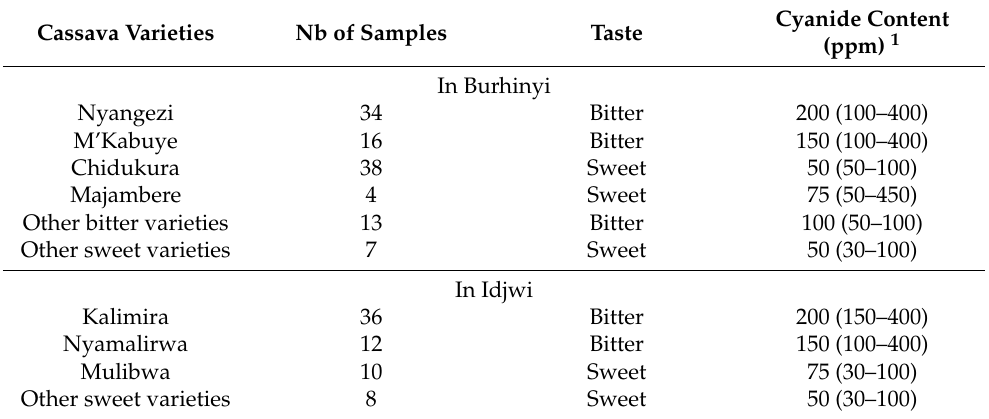
Table 2. Varieties and cyanide content in (fresh) cassava roots grown in Burhinyi and Idjwi. Cassava